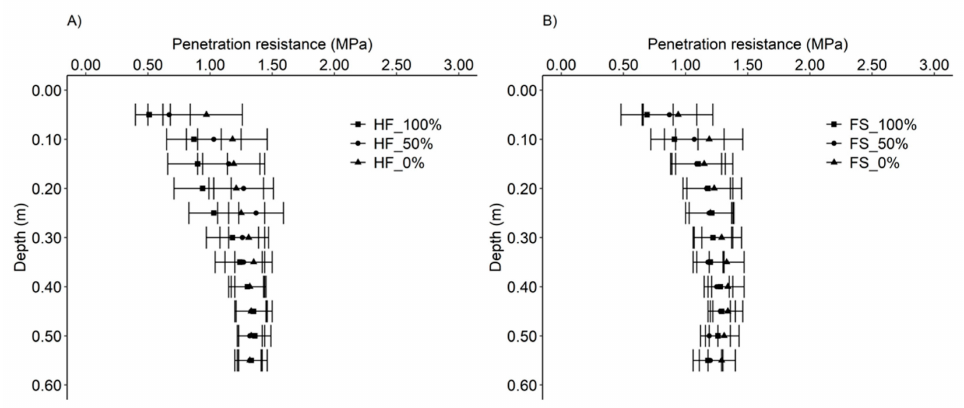
Figure 4. Soil penetration resistance (PR) up to 0.60 m depth in eucalypt cultivation areas under stand renewal with different straw levels (100, 50, and 0%) and harvested with ( A ) harvester + forwarder (HF) and ( B ) feller + skidder (FS) systems. Bars refer to the confidence interval (90%) of the average (n =